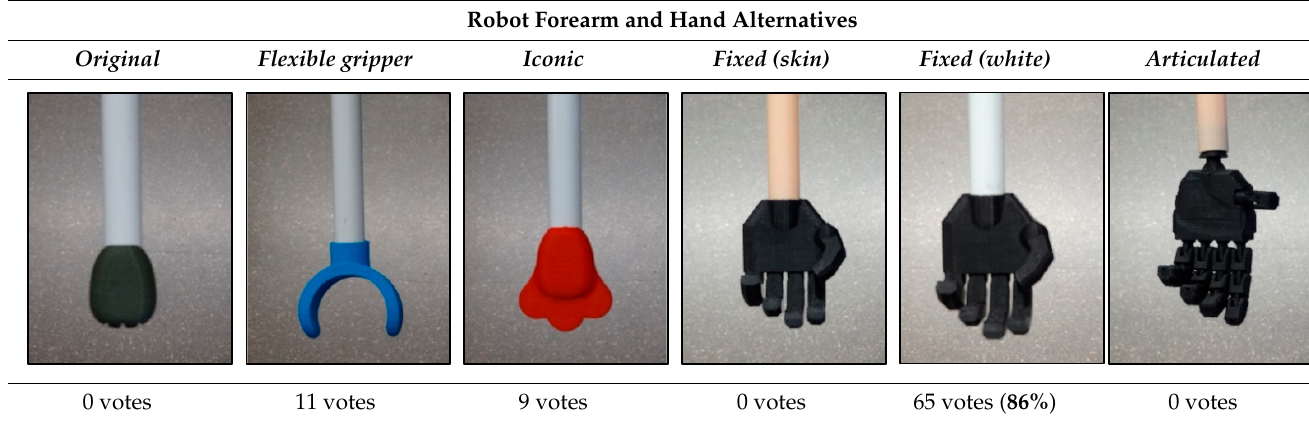
Table 4. Alternatives considered to implement the forearm, arm and hand and votes received. Robot Forearm and Hand Alternatives